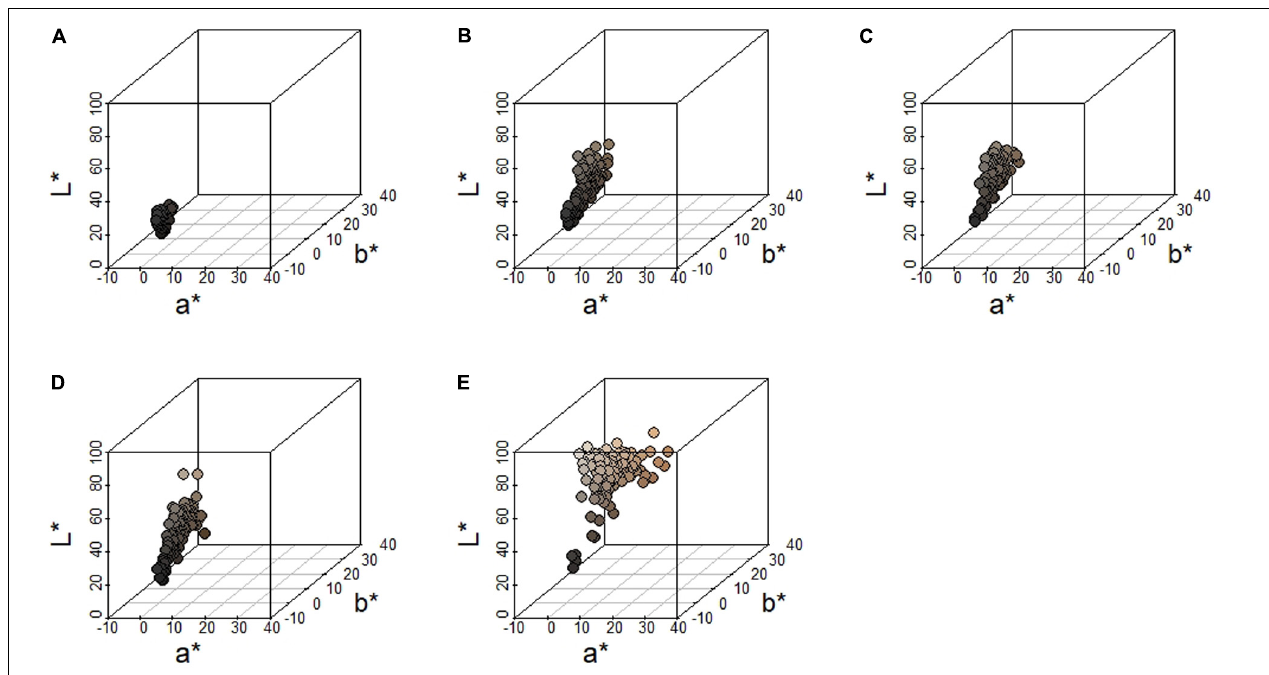
FIGURE 4 | Distribution of color measurements along the L* (dark to light), a* (green to red) and b* (blue to yellow) axes from eastern fox squirrels (A) head, (B) shoulder, (C) rump, (D) dorsum, and (E) venter. Each circle represents an individual squirrel and the fill color of each circle matches the color